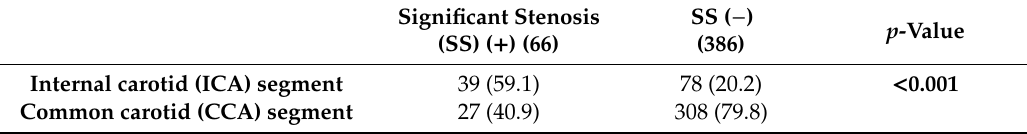
Table 3. Comparison location of